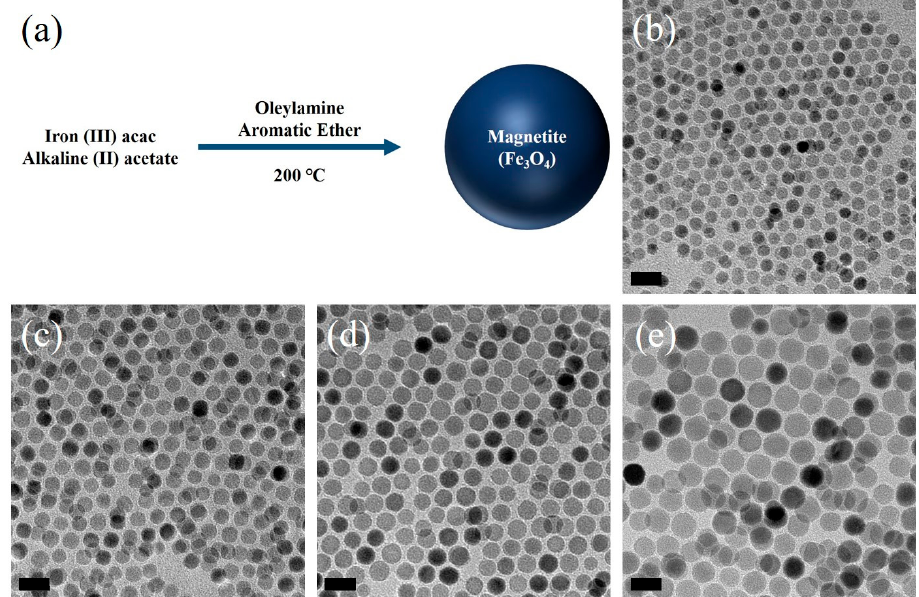
Figure 1. Spherical magnetic nanoparticles with the alkaline metal reagent. ( a ) Schematic formation path of spherical magnetite nanoparticles assisted by alkaline metal complexes. TEM images of monodisperse magnetite nanoparticles with sizes of ( b ) 8 nm, ( c ) 11 nm, ( d ) 15 nm, and ( e ) 18 nm with the different volume ratio of oleylamine/ether. Scale bar is 20 nm.